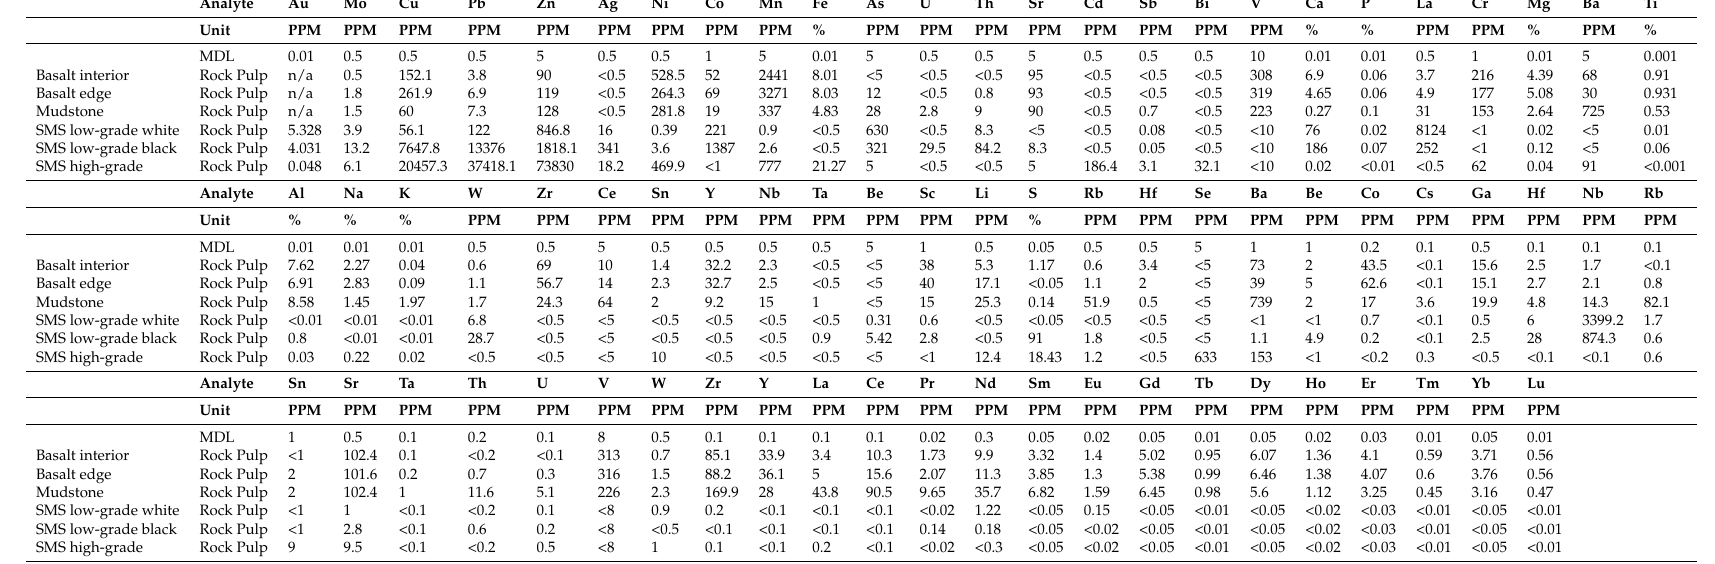
Table A1. Table of elements from ICP-ES/MS, reproduced with permission